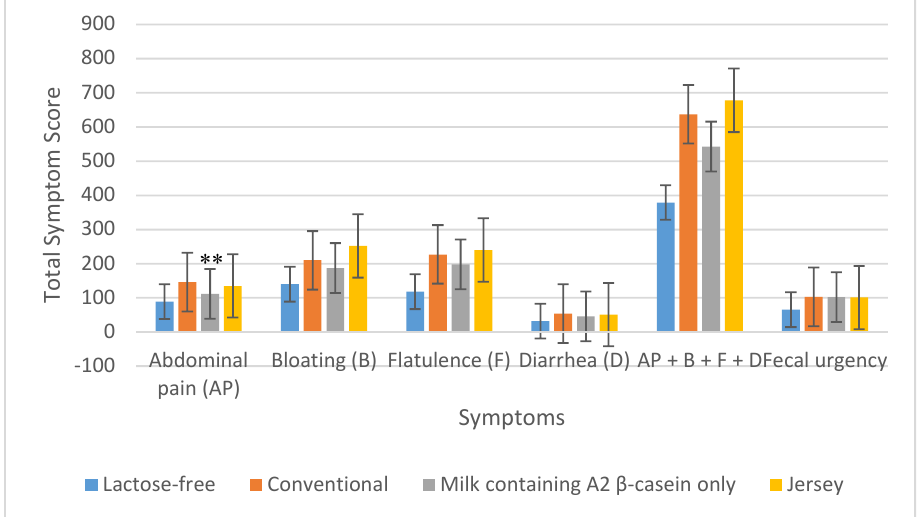
Figure 2. Total symptoms reported during the 6 h after consuming the four milk products in 25 lactose